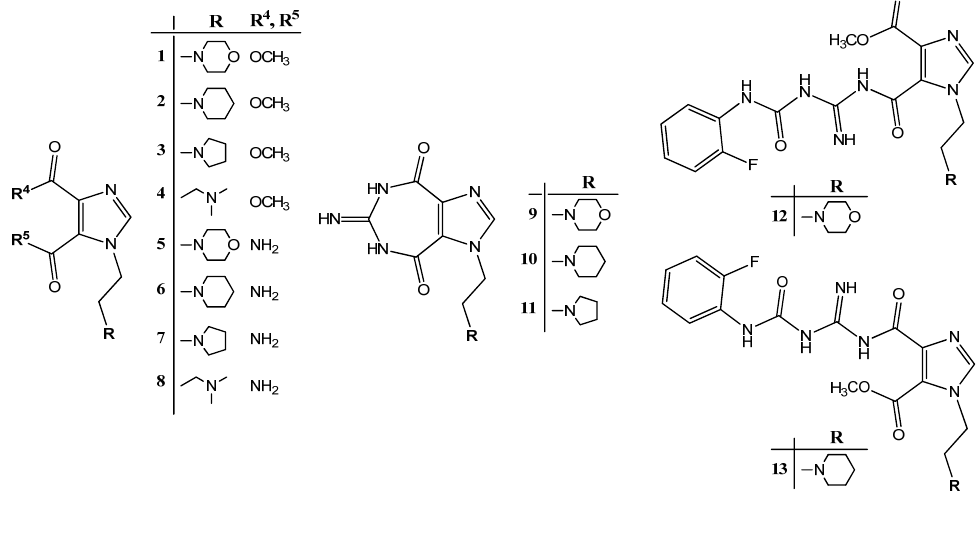
Figure 2. Synthesis of imidazo[4,5-e][1,3]diazepine-4,8-dione ( 9 – 11 ) and ureido-imino-carbamoyl-imidazole derivatives ( 12 – 13 ). Reagents and conditions: CO , CH CN, r.t.; ( ii ) NH , MeOH, r.t.; ( iii ) guanidine hydrochloride, ( i ) K 2 3 3 3